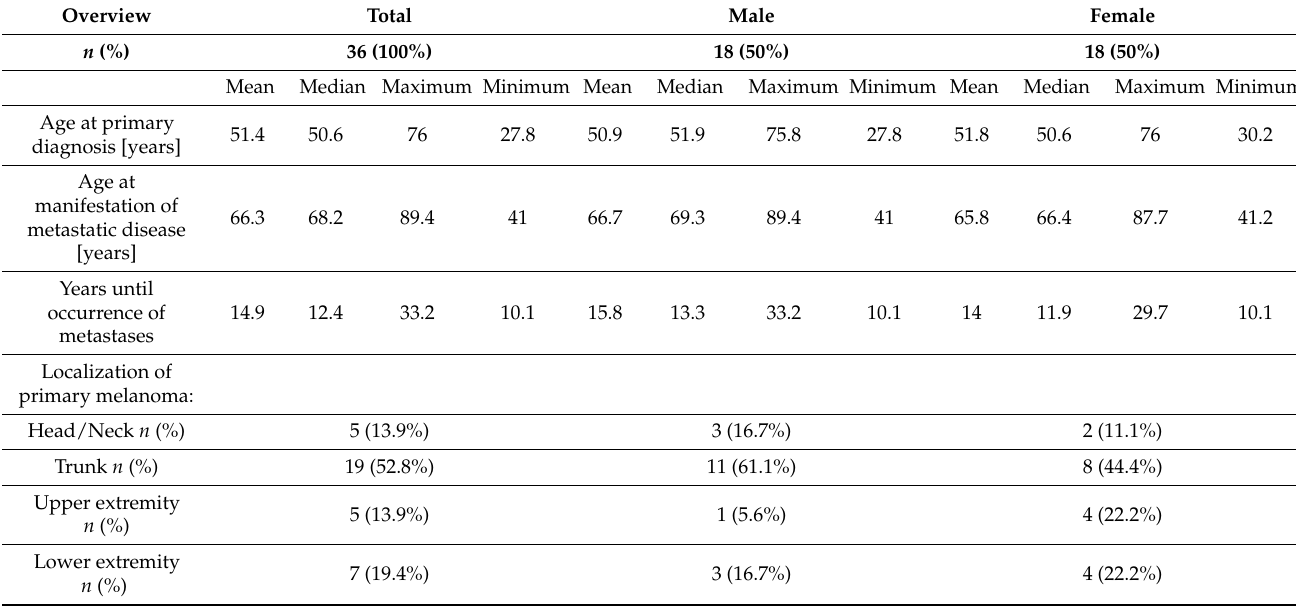
Table 1. Characteristics of study collective, gender comparison.